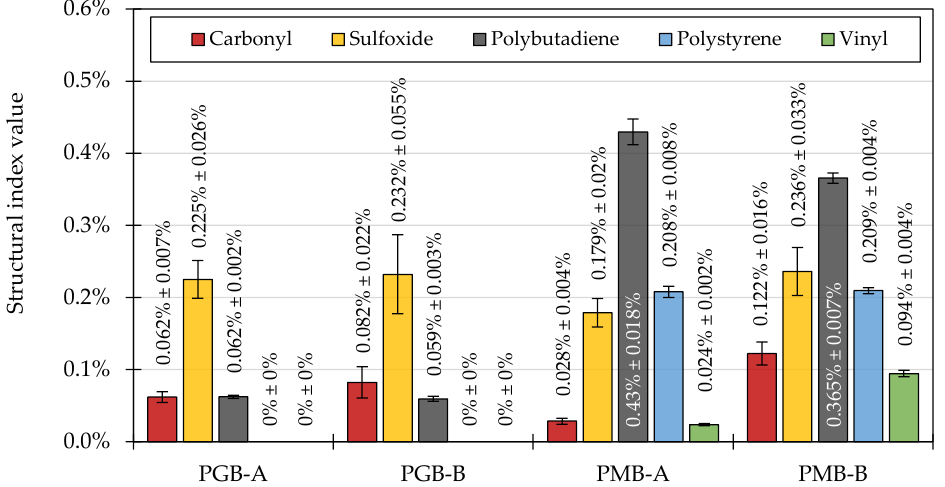
Figure 7. Values of the structural indices calculated based on the ATR-FTIR spectra of the investigated binders.